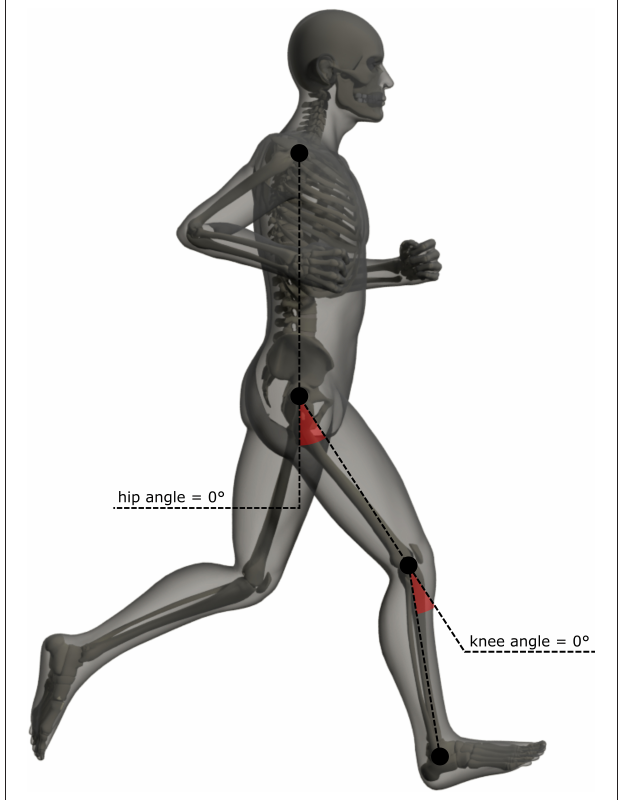
FIGURE 1 | Lower-limb kinematic angles. Areas shaded red indicate the angles analyzed (sagittal plane of the hip and knee joint, respectively). Filled black circles closest to the red areas represent the joint center of the hip and knee. Dashed lines indicate 0 ◦ for the